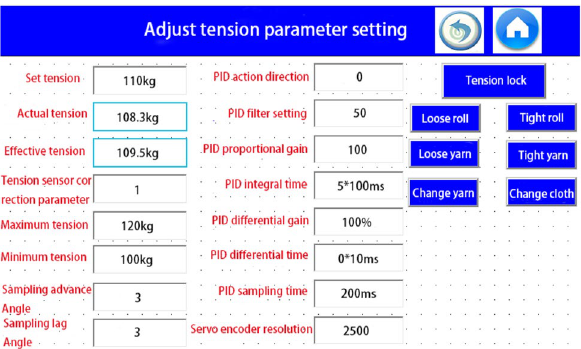
Fig. 21 Adjust tension parameter setting